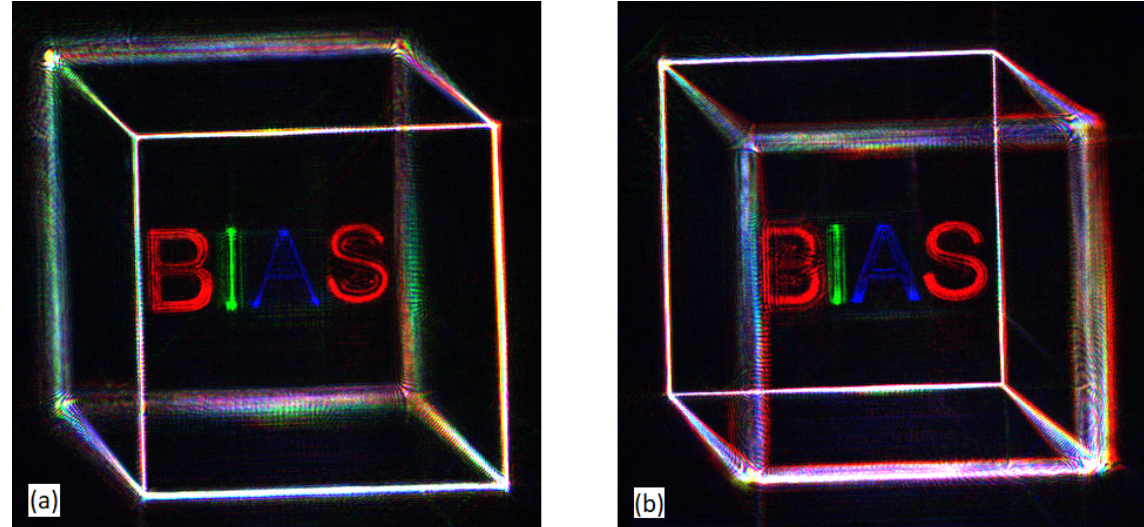
Figure 4. Multicolor 3D scenes displayed by temporal multiplexing of three separate wavelengths (633 nm, 532 nm, and 488 nm), with the three color channels being recorded in temporal sequence. Displayed is a tilted wire frame cube with constant intensity across all three colors, resulting in an approximately uniform white appearance. The edges of the cube are 5 mm long, with the front and rear sides of the cube displayed at 150 mm and 130 mm in front of the SLM plane, respectively. Inside the cube, the letters BIAS are displayed in different colors, laying in four distinct depth planes between 150 mm and 130 mm from the SLM plane. In ( a ) the recording setup is focused on the front plane of the cube in which the letter B also lies, the rear plane and the other letter appearing out of focus, displaying a distinct depth impression. Instead, in ( b ) the rear plane and the letter S are in